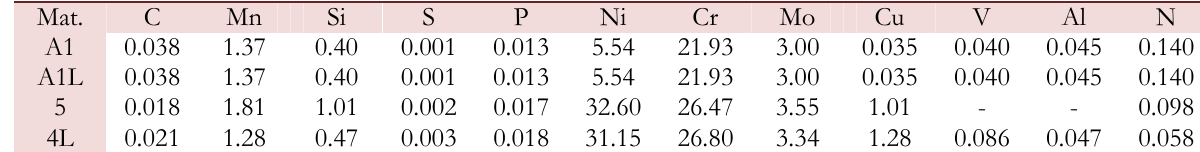
Table 1: Investigated steels chemical compositions.